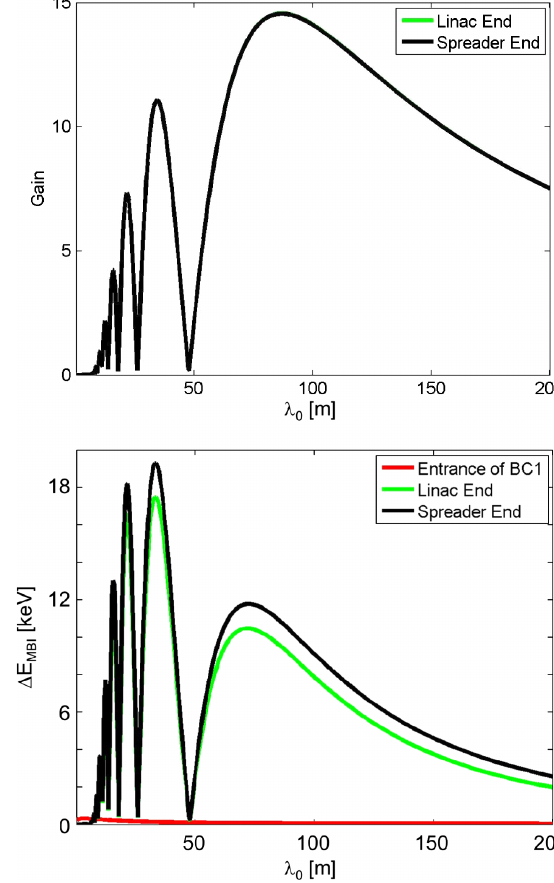
FIG. 6. Top: Linear optics functions along the FERMI spreader for the present optics design. Middle: Linear optics functions along the spreader for the new optics design. Bottom: R 56 along the spreader for the present and the new optics design.